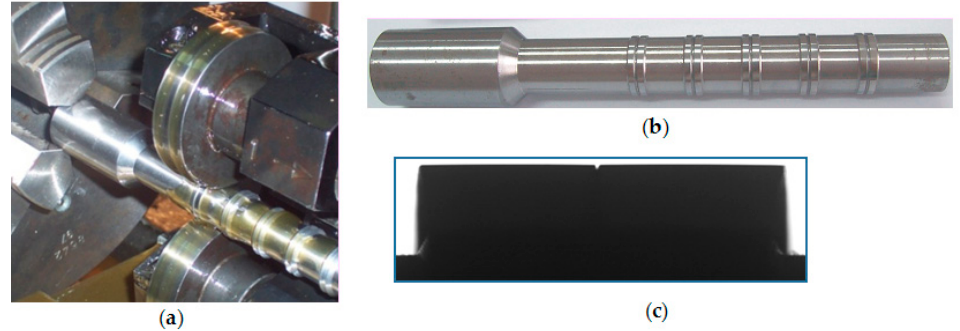
Figure 5. Burnishing position ( a ), general view of the shaft with the samples after burnishing ( b ), zoom of the asperities after roller burnishing ( c ).